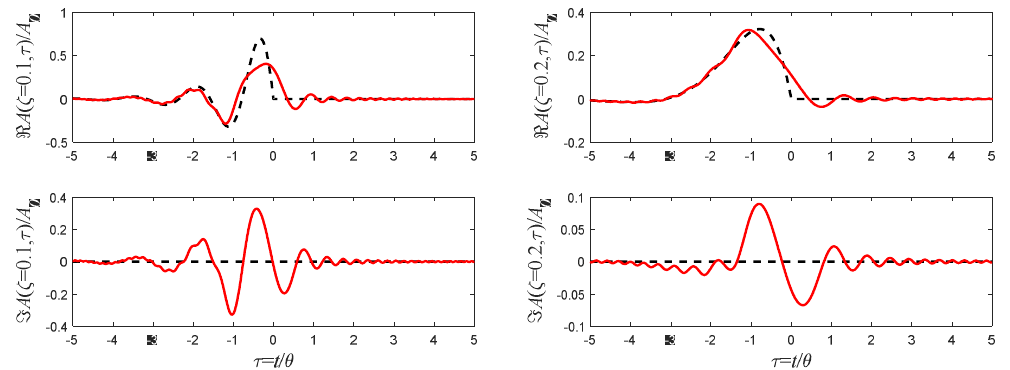
Figure 16. Similar to Figure 10, but for the pulse presented by Equation (53). In these plots, a = 1/ θ on both, but b = 4/ θ on the left figure (final distance corresponds to ζ = β 2 z / θ 2 = 0.1) and b = 1/ θ on the right one (final distance corresponds to ζ = β 2 z / θ 2 = z ).